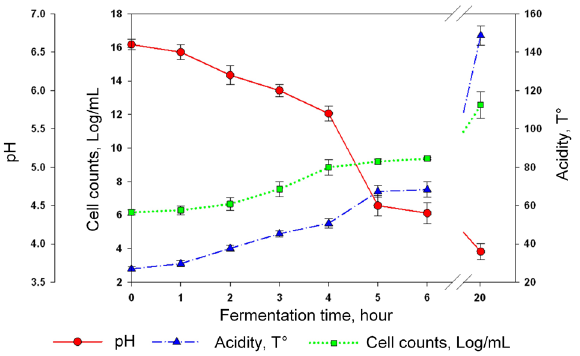
Fig. 1. Fermentation profile of Lactobacillus